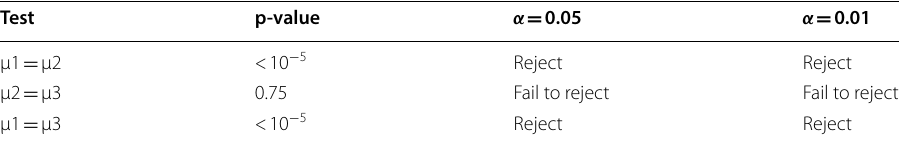
Table 9 Z test—results